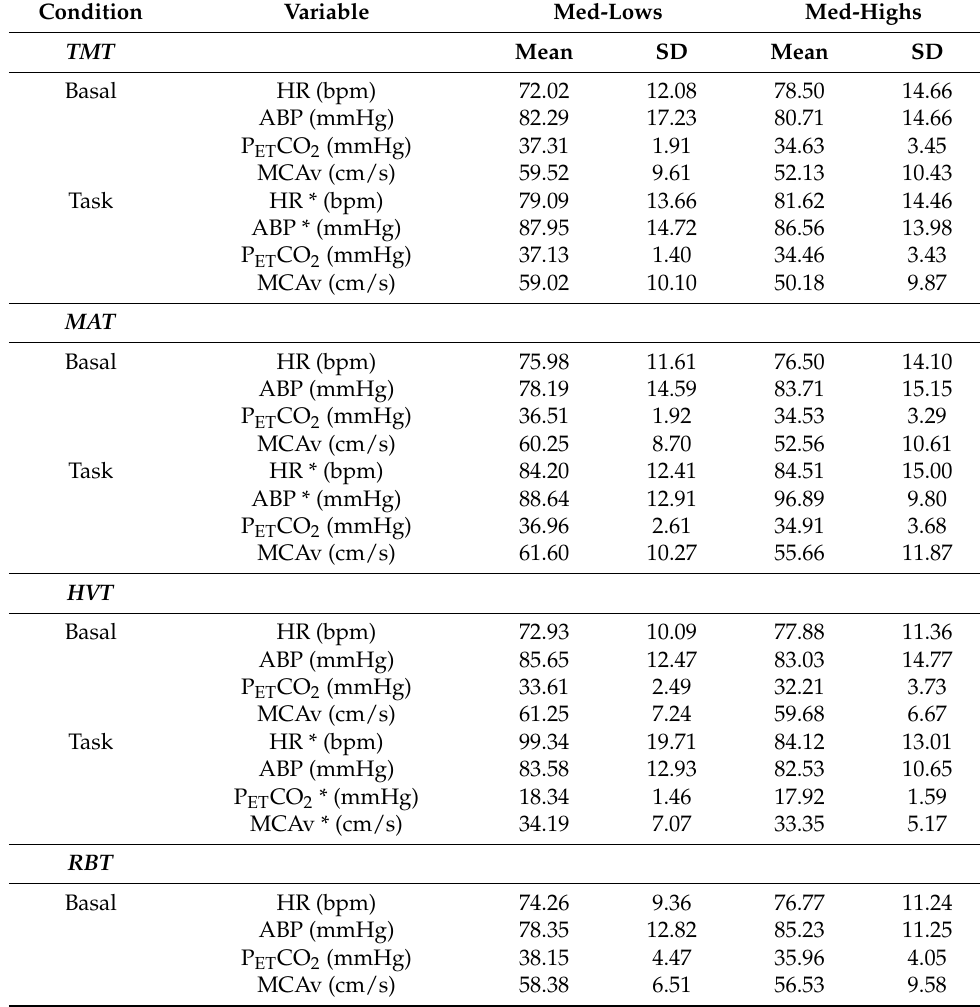
Table 1. Variable mean values and standard